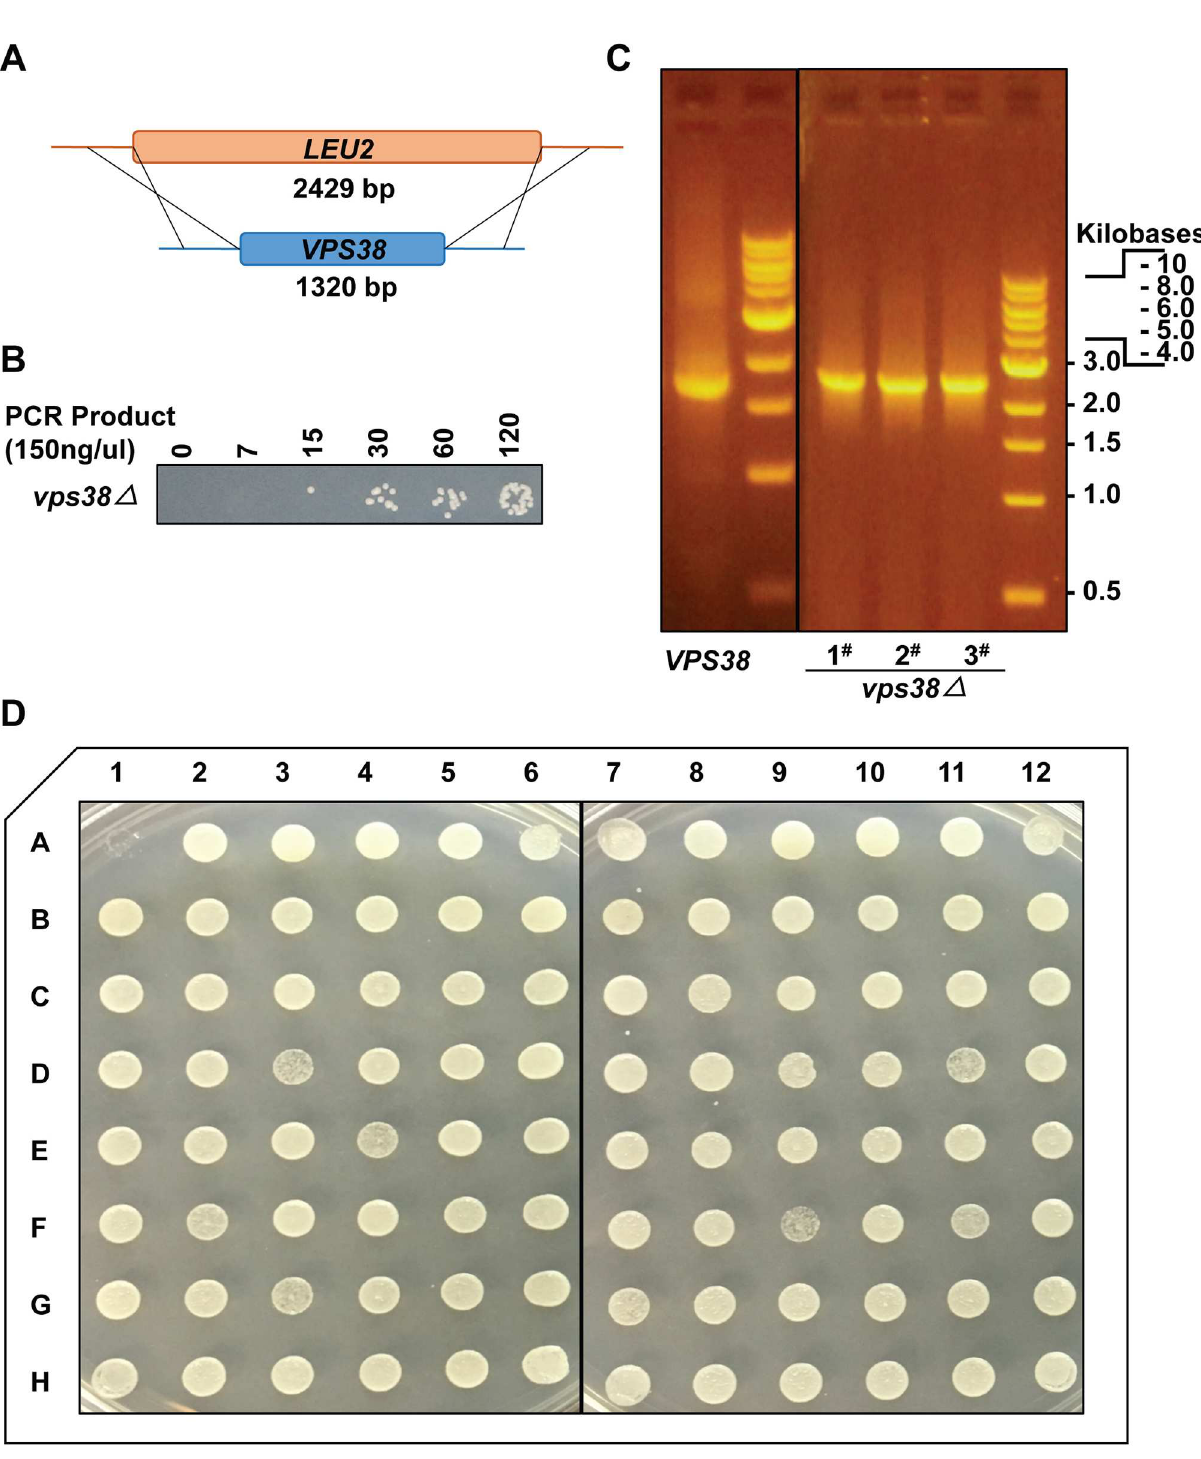
Fig 3. Successful application of high-throughput transformation method to gene deletion. (A) Generation of VPS38 knockout strain by insertion via homologous recombination of a LEU2 selective marker at the VPS38 locus. (B) Different volumes of 150ng/ulof the LEU2 cassette were transformed into yeast cells. Transformants were platedon—Leucinemedia. (C) VPS38 deletionwas verified using check primers (Table 2) from four singlecolonies(wild type, 1#: 30 μ l spot, 2#: 60 μ spotl, 3#: 120 μ l spot). Expected PCR product size of wild type: 1701bp, VPS38 knockout: 2810 bp. (D) Plate 1 from the non-essential yeast knockout library was cultured and transformed with 4500ng VPS38 knockout LEU2 cassette using our methodology. Transformed cells were cultured in –LeucineSD media for 3 days and spotted on – Leucinemedia using